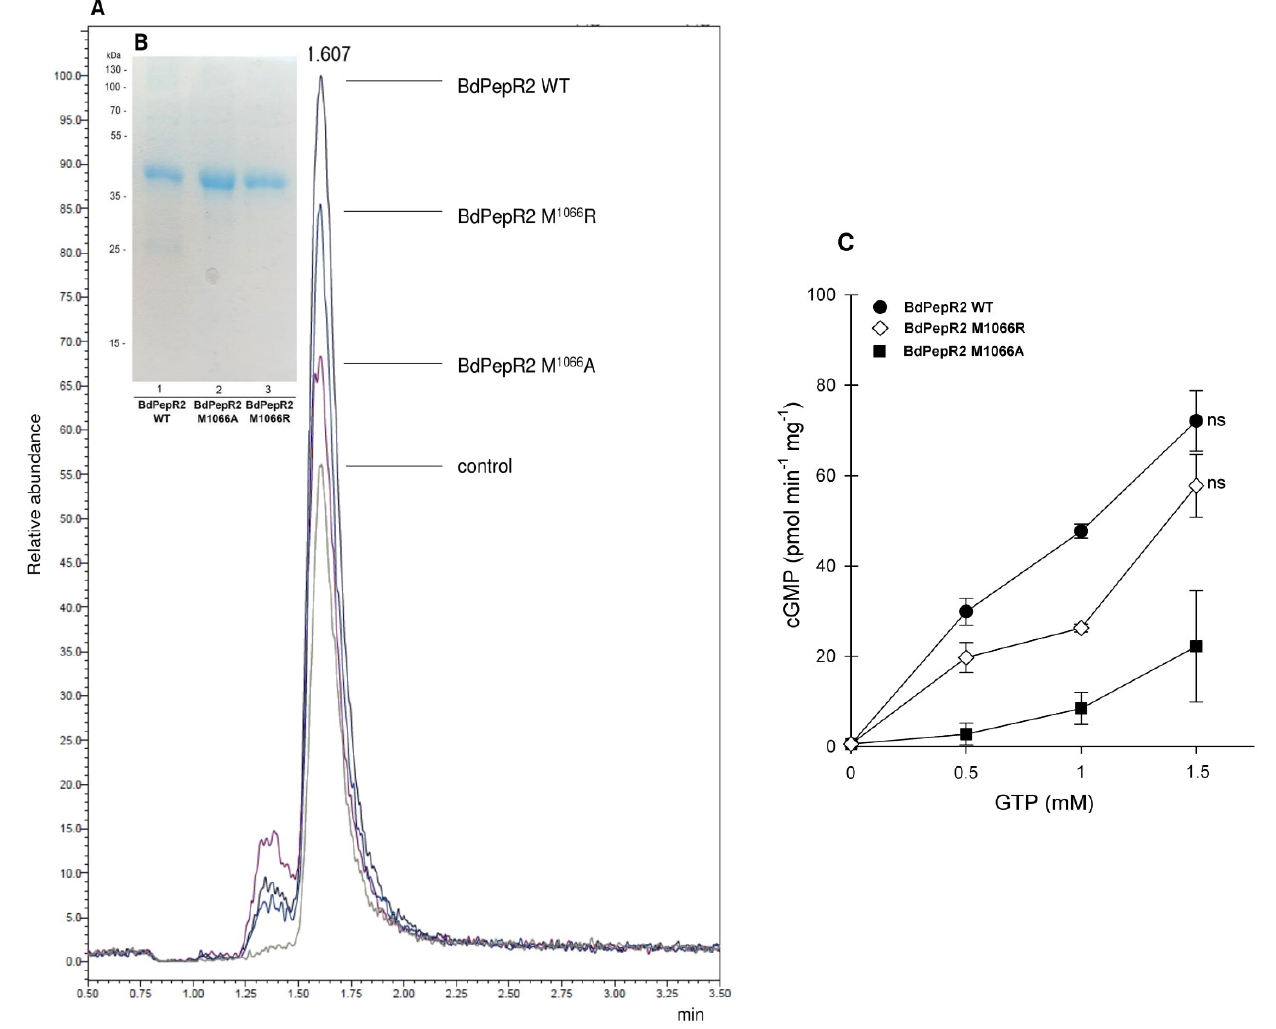
Figure 5. Detection of cGMP generated by BdPepR2 WT, BdPepR2 M1066A, and BdPepR2 M1066R by LC-MS/MS ( A ) Four superimposed ion chromatograms of cGMP generated by 5 μ g recombinant BdPepR2 WT (black), BdPepR2 M1066R (blue), BdPepR2 M1066A (purple), and control (no protein, grey) after 15 min in the presence of 5 mM Mn 2+ . ( B ) SDS-PAGE of BdPepR2 WT, BdPepR2 M1066R, BdPepR2 M1066A. ( C ) LC–MS/MS quantification of cGMP levels generated by BdPepR2 recombinant and mutant proteins with Met1066 substituted with Arg or Ala in presence of various GTP concentrations and 5 mM MnCl 2 after 15 min at 30 °C. Data are mean values (n = 3), and error bars show standard error of mean. Statistical analysis was performed by one-way ANOVA followed by a Tukey–Kramer multiple comparison test. ns indicates not significantly different data.